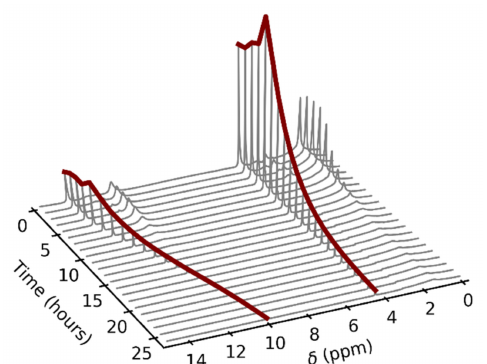
Figure 4. An example of the time dependence of the acetic acid 1 H–NMR spectra in the fluorinated ethylene propylene copolymer (FEP) insert at the temperature of 80 ◦ C. The gas-phase signals are highlighted by red color. The spectra were not referenced.